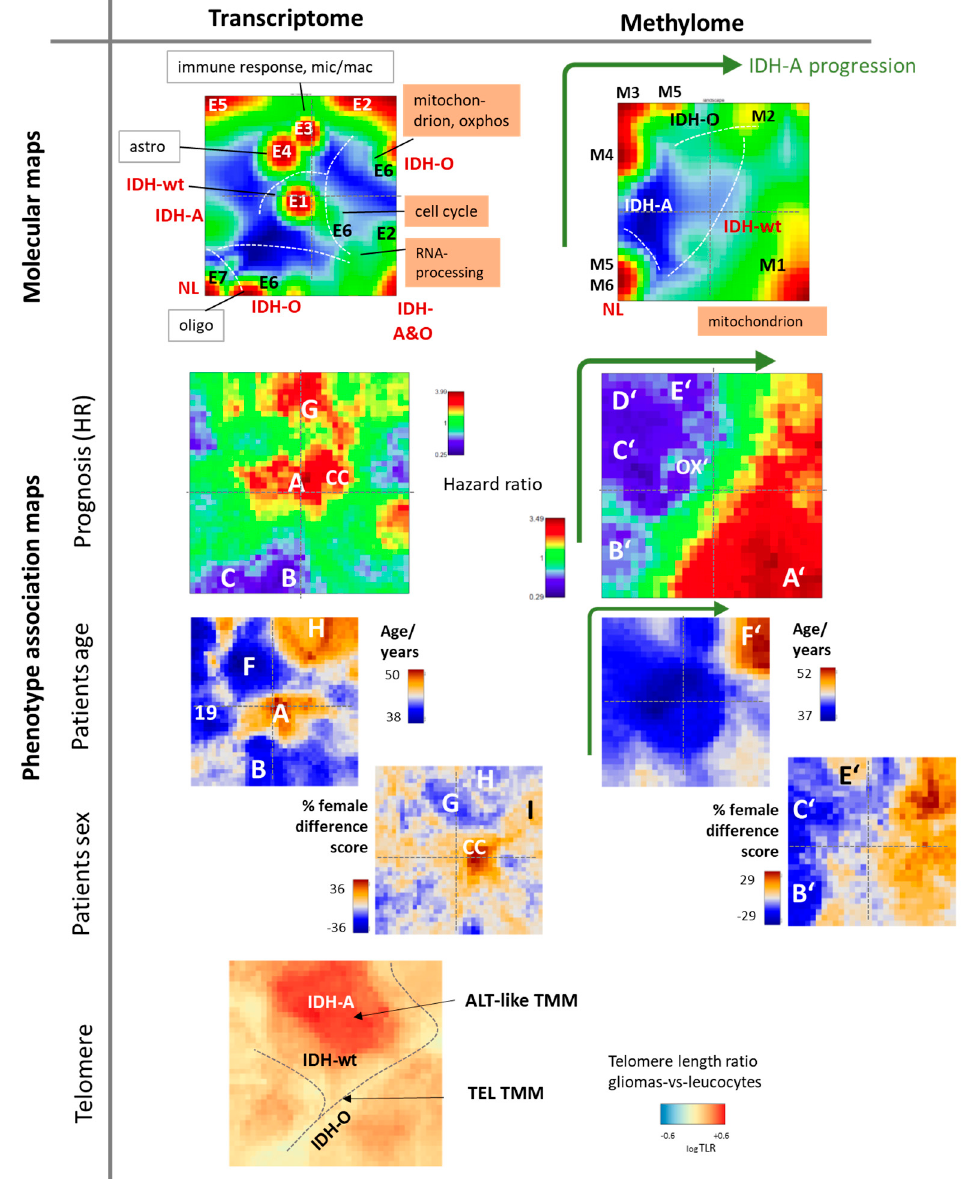
Figure 8. Molecular and phenotype maps of the transcriptome (left part of the figure) and methylome (right part) landscapes of LGG. Phenotype maps show associations between gene expression and promoter methylation with the hazard ratio (HR), patient’s age at first diagnosis, sex of the patients, and telomere length ratio between tumor and leukocytes (TLR). Phenotype maps were generated as described in Figure S7 for prognostic maps. The ‘female difference score’ estimates the deviation from the mean percentage of female patients in units of ‘percent-of-percent’. Overall, phenotype maps enable the comparison of expression and methylation levels in the different subtypes with the respective phenotype features.